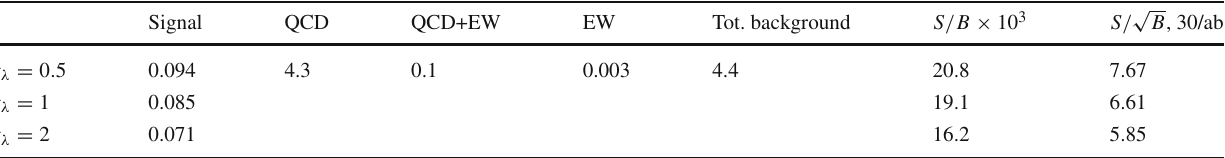
Table 9 Results for the boosted 4 b -jet analysis of pp → hhj , Sect. 3. We include results for three different choices of the self-coupling within the κ framework [64], κ λ = λ/λ SM . Numbers to the left of the double vertical lines are in femtobarns